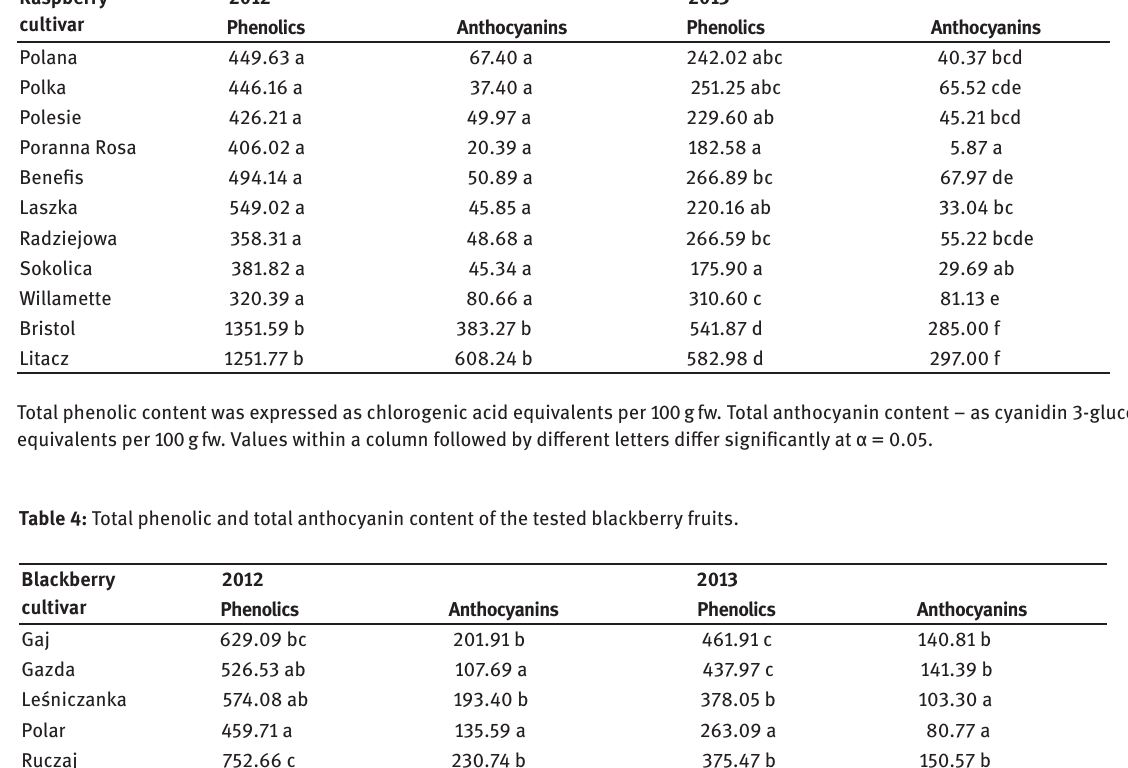
Table 3: Total phenolic and anthocyanin content of the tested raspberry fruits. Raspberry cultivar